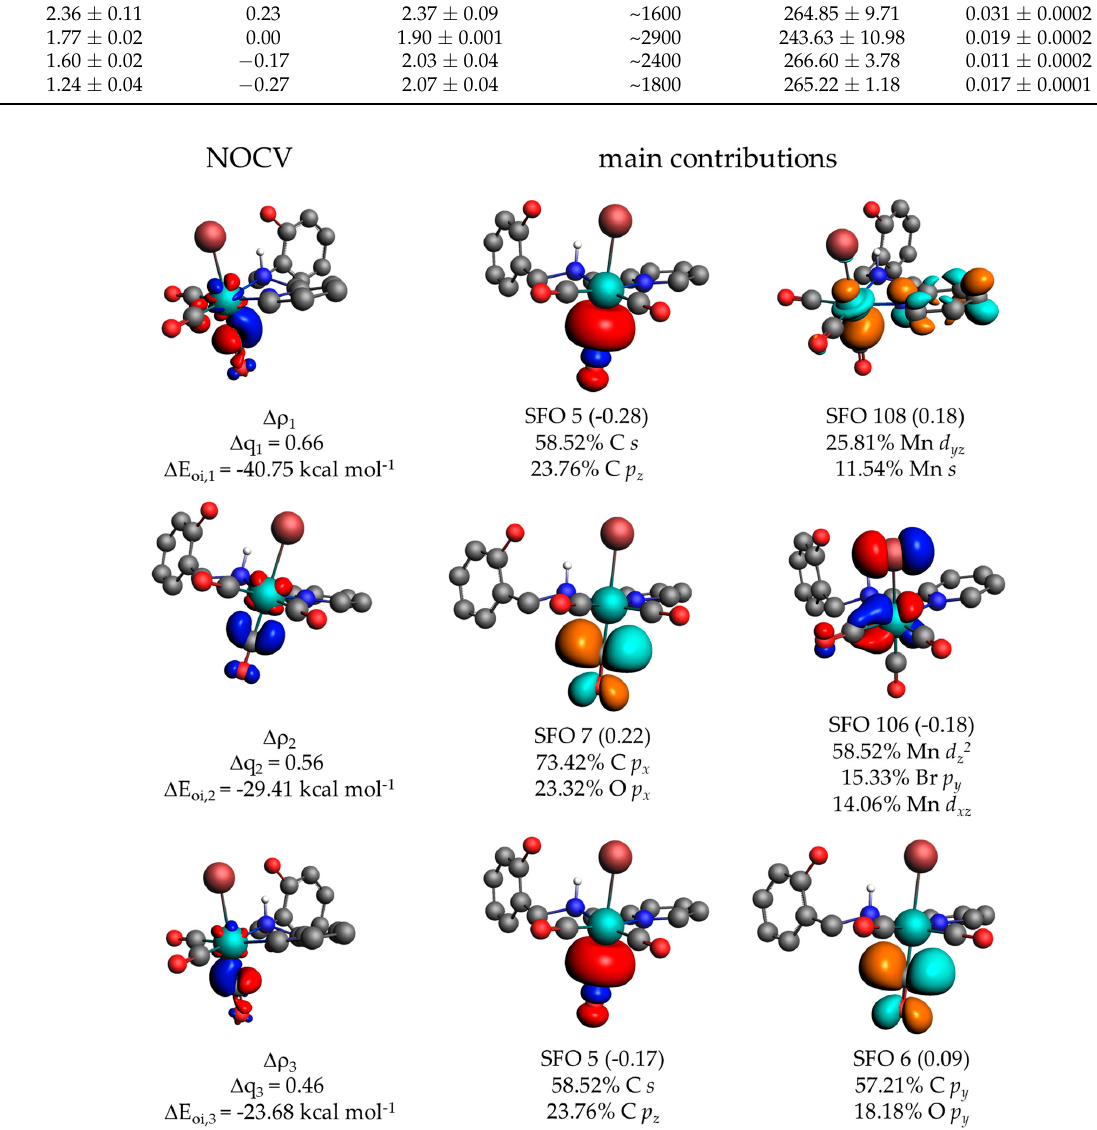
Figure 7. Plot of the most relevant density flow channel ( Δ ρ ) contributing more than 2.0 kcal mol − 1 with their respective energies ( Δ E oi ) and charge transfer estimation ( Δ q) values for fragment 1-CO ( trans to bromide) of compound ( 2a ) and the associated orbitals of the fragments with the greatest contribution for each density flow channel. The direction of the charge flow is red to blue, where red means density depletion, and blue means density increment. Hydrogens attached to carbon are omitted for clarity. The isovalue for the NOCV is 0.005, and for the SFO it is 0.05.